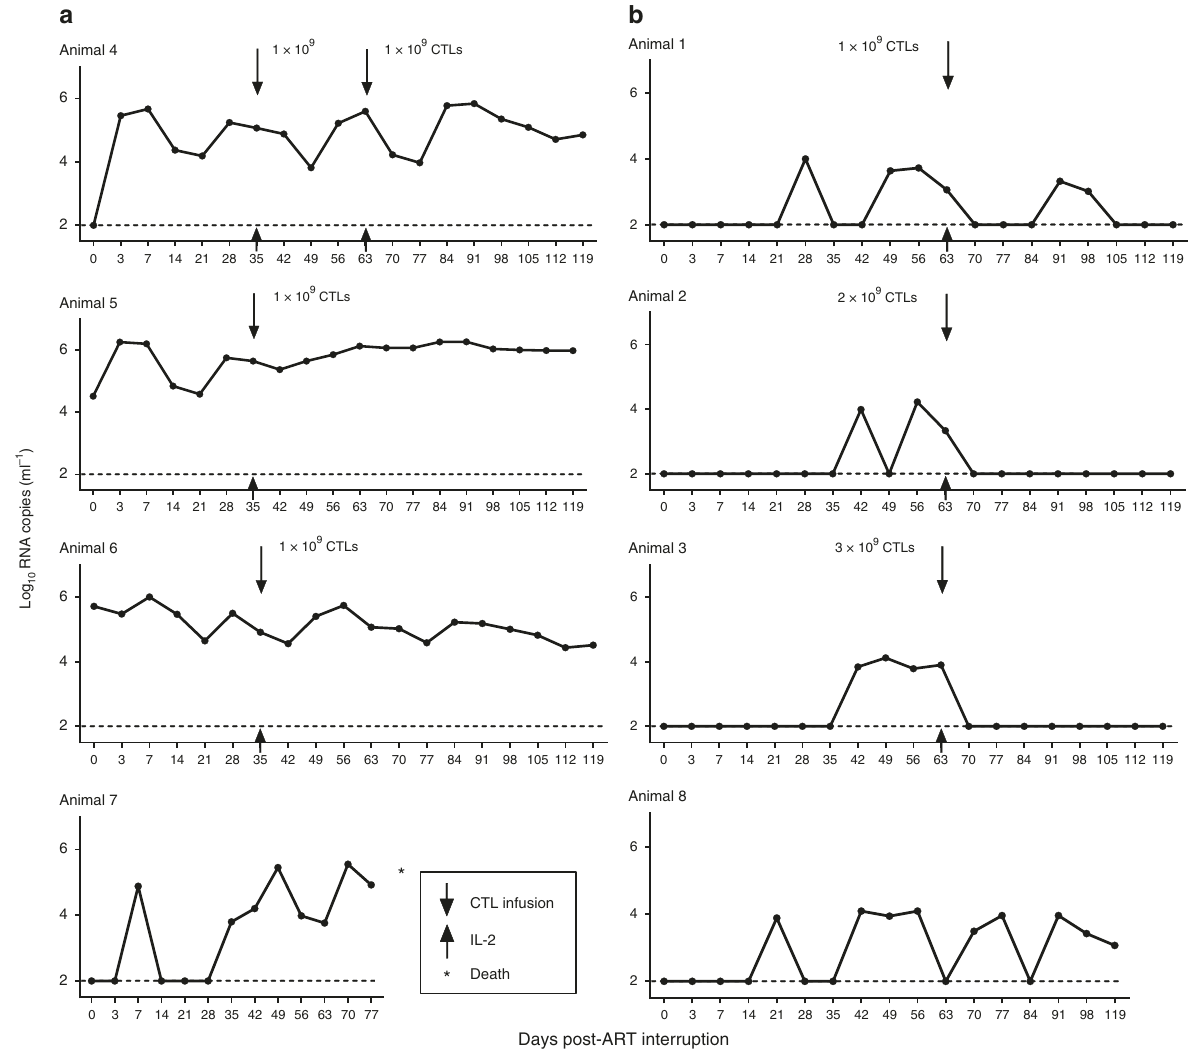
Fig. 2 Viral RNA following ART discontinuation. Log viral RNA copies per ml are shown (limit of detection, 2 Log RNA copies per ml). a Macaques ( n = 4) with high viral burden after ART interruption. b Macaques ( n = 4) with low viral burden after ART